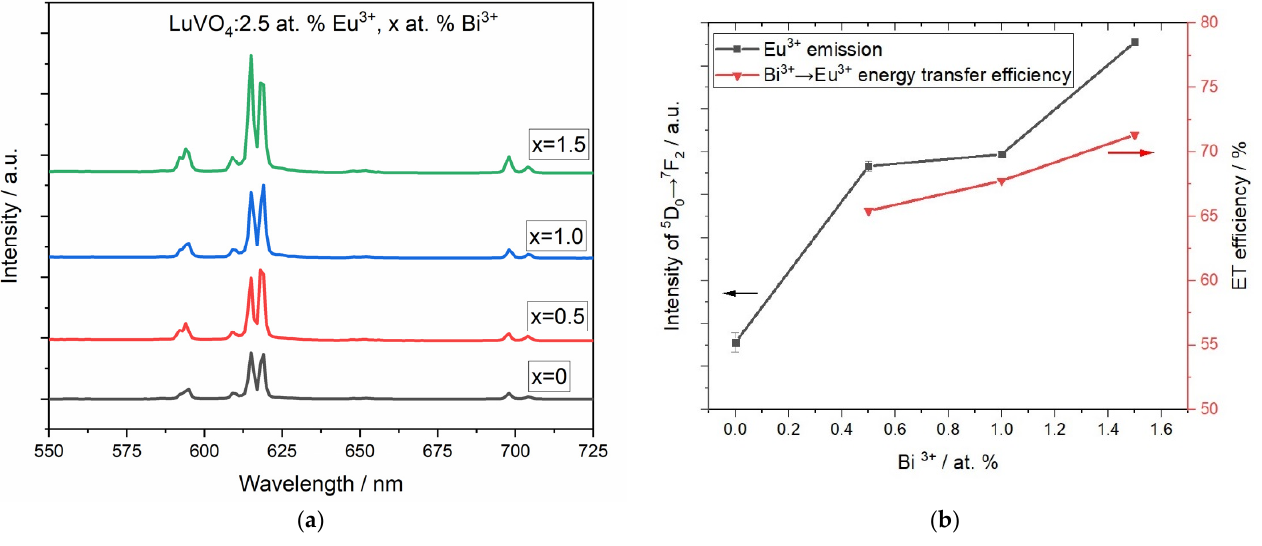
with an ET efficiency of 50% [53].